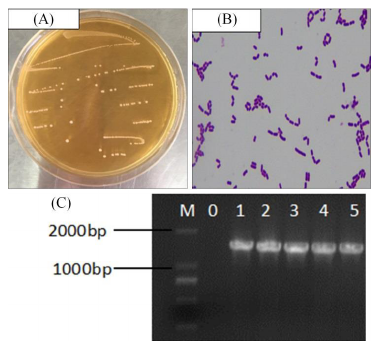
electrophoresis of PCR amplified product of Lactobacillus plantarum CQPC05. M: 2000 bp DNA Ladder; 0: negative control group; 5: Lactobacillus plantarum